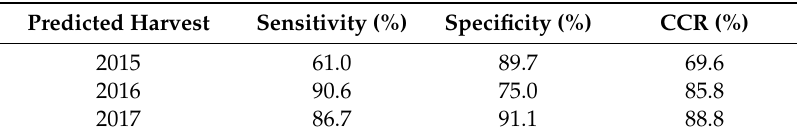
Table 3. SIMCA modelling results of class BA (FT-MIR data) according to the di ff erent harvesting seasons, expressed as sensitivity, specificity and overall correct classification